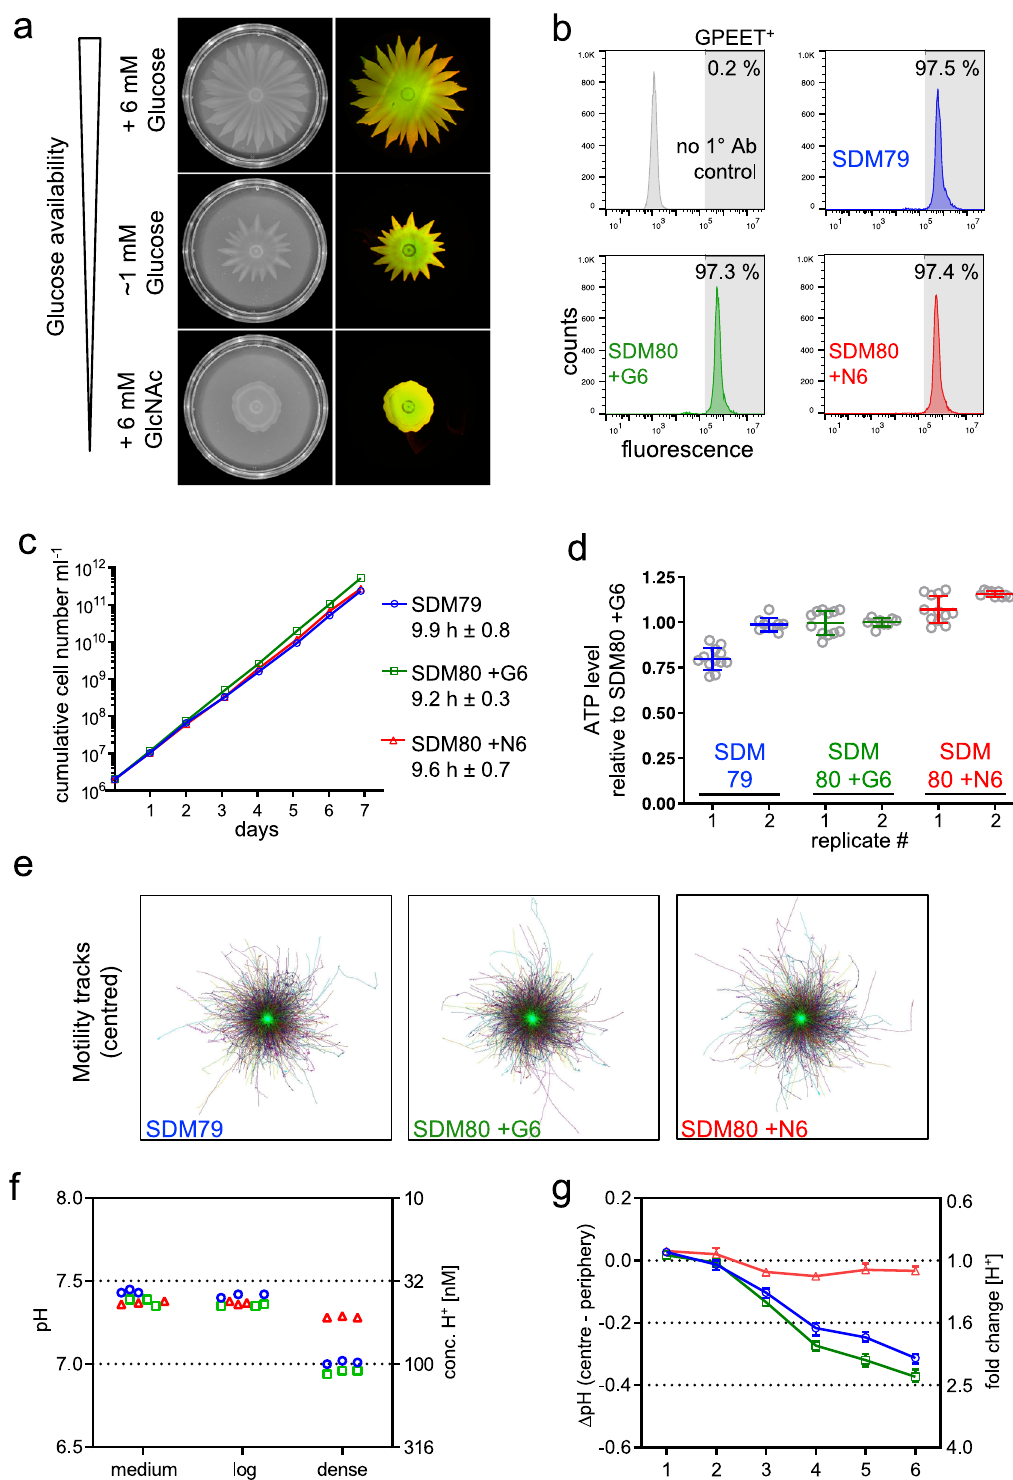
single knockouts of ACP1 and ACP5 (Supplementary Fig. 6a, 7a) implying that they are essential at this stage of the life cycle. Although we attempted to knock out ACP3, and isolated resistant cell lines, the antibiotic resistance genes were not integrated at the correct locus. The full knockout of ACP6 and the semi-knockout of ACP1 both exhibited hyper-SoMo phenotypes, while the full knockout of ACP2 showed no phenotype (Supplementary Fig.